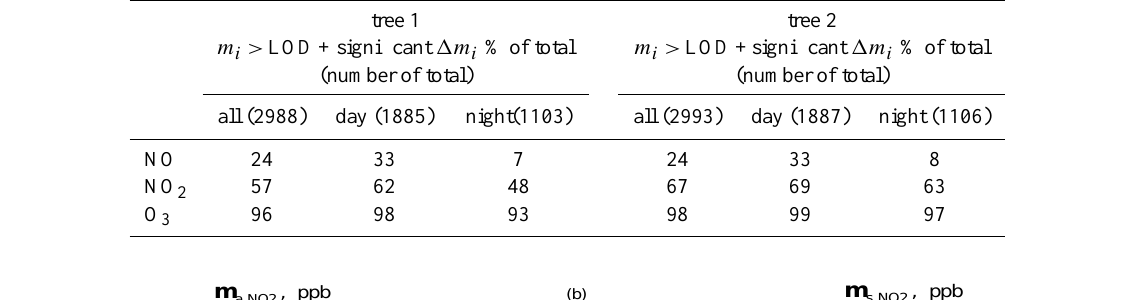
Table 8. Percentage of data m i ( i =NO, NO 2 , O 3 ) above limit of detection (LOD ( m i ), 3 σ -definition) and significant differences − m 1m i =( m a,NO s,NO 2 ) of tree 1 and 2 for field measurements. 2